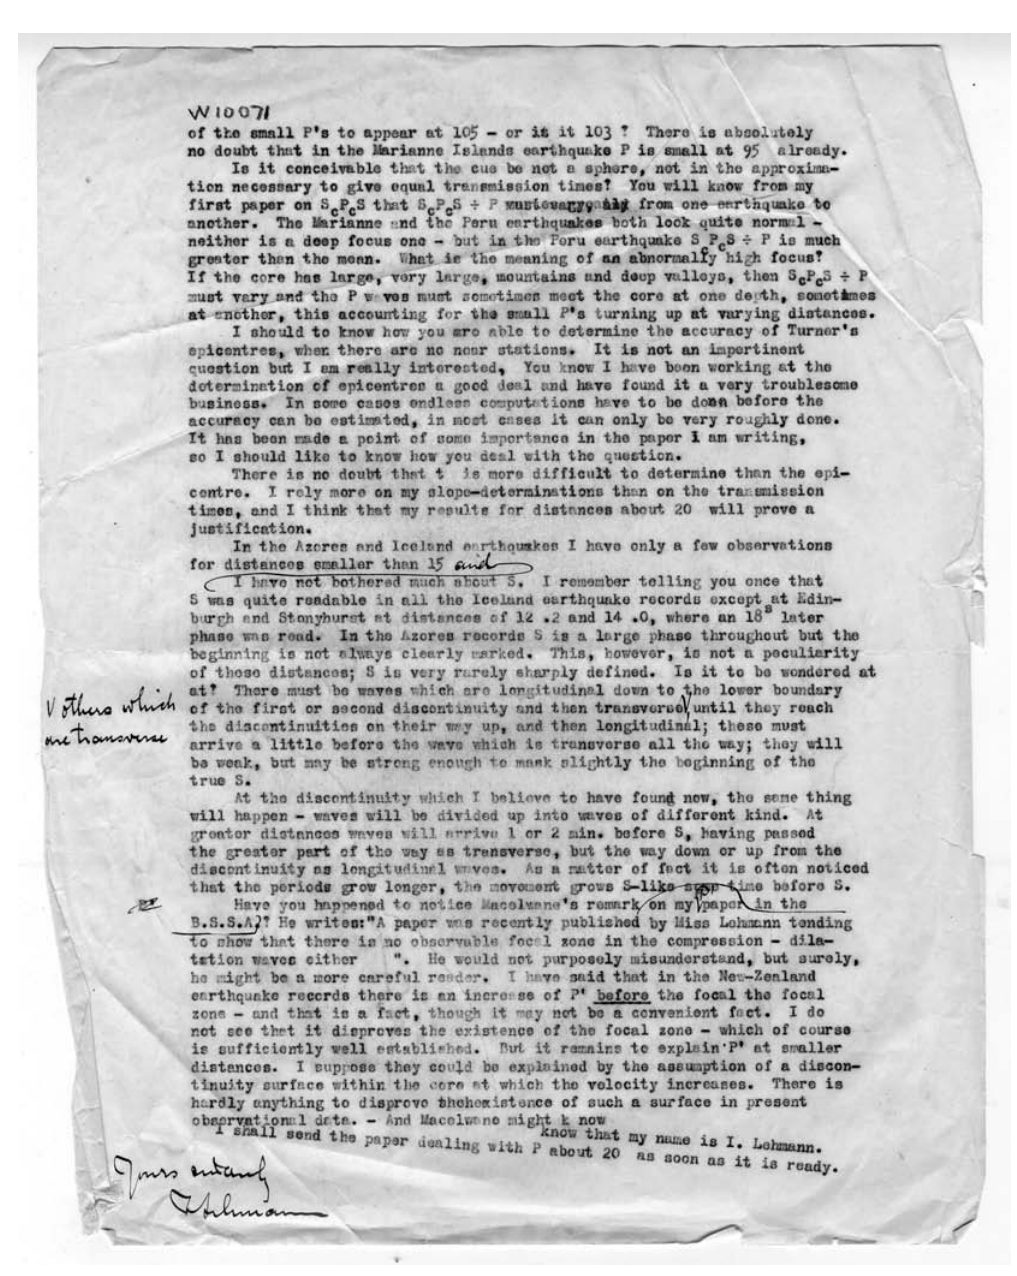
Fig. 3. Second page of Inge Lehmann’s May 31, 1932 letter. Only the last 15 lines are about the inner core. They deal with the «increase of P’ before the focal zone». «I suppose they could be explained by a discontinuity sur- face within the core at which the velocity increases». In the paragraphs before the last 15 lines one or two dis- continuities in the upper layers are